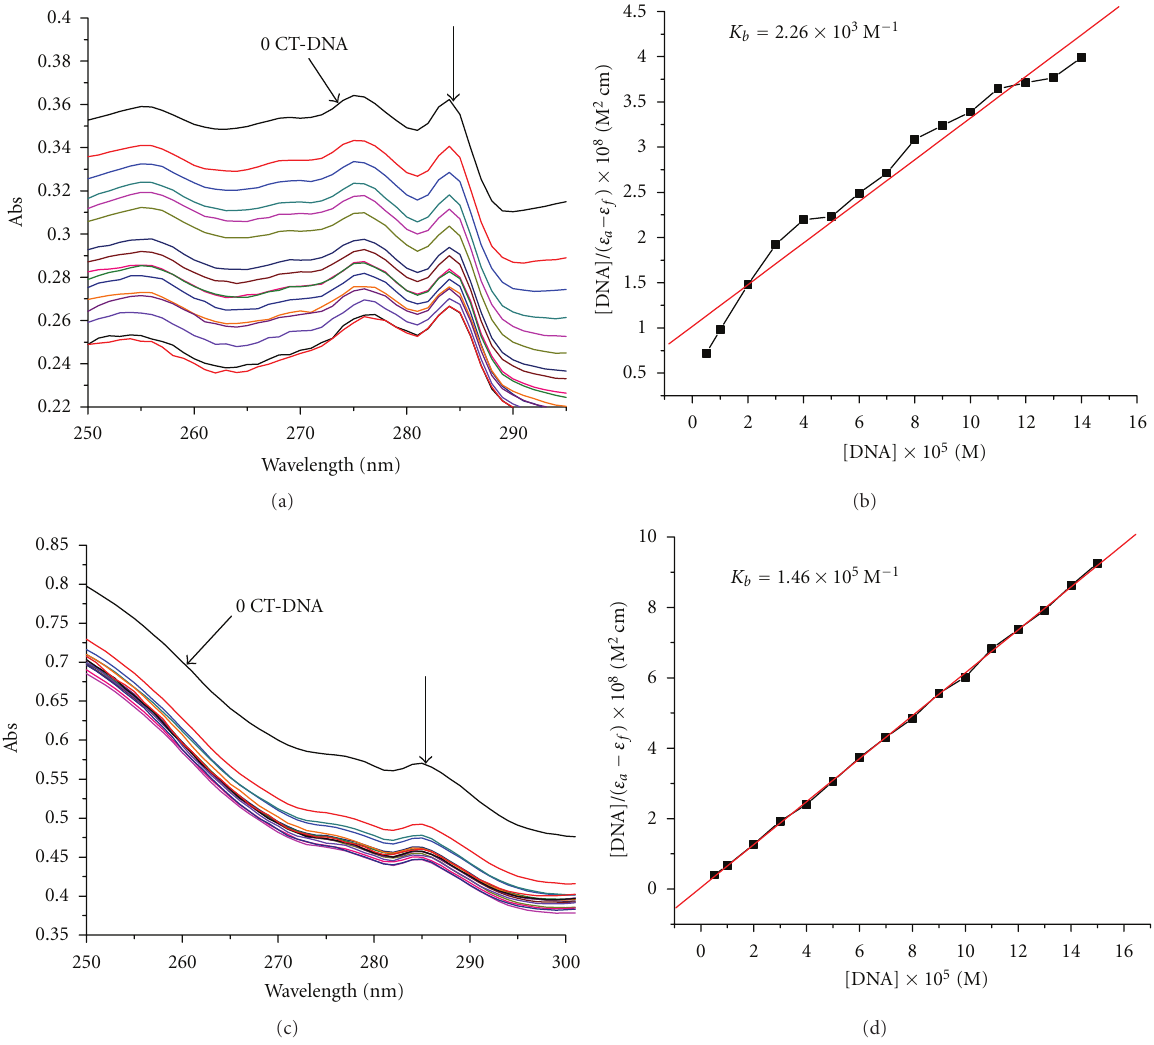
Figure 2: Absorption spectra of the ligand babb (a), Cd (II) complex (c) (3 × 10 − 5 molL − 1 ) in the absence and presence of increasing amounts of DNA (0–15 × 10 − 5 mol L − 1 ) in 5 mmol L − 1 Tris-HCl/50mmol L − 1 NaCl bu ff er (pH = 7.2). The arrow shows absorbance changes on increasing DNA concentration. Plot of [DNA] / ( ε a − ε f ) versus [DNA] for absorption titration of DNA with the ligand babb (b), Cd (II) complex